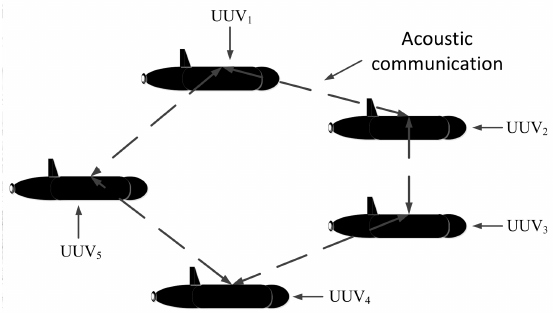
Figure 1. Unmanned Underwater Vehicles (UUV) cooperative navigation system—parallel UUV cooperative navigation